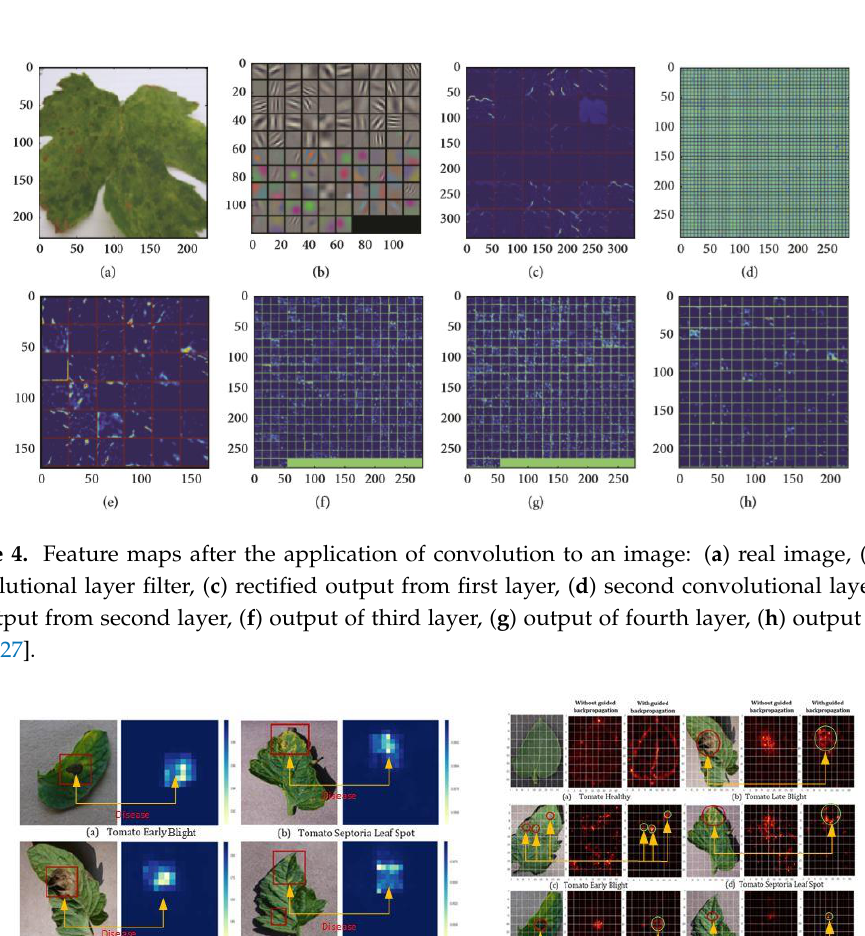
Figure 6. Detection of maize disease (indicated by red circles) by heat map [70] .